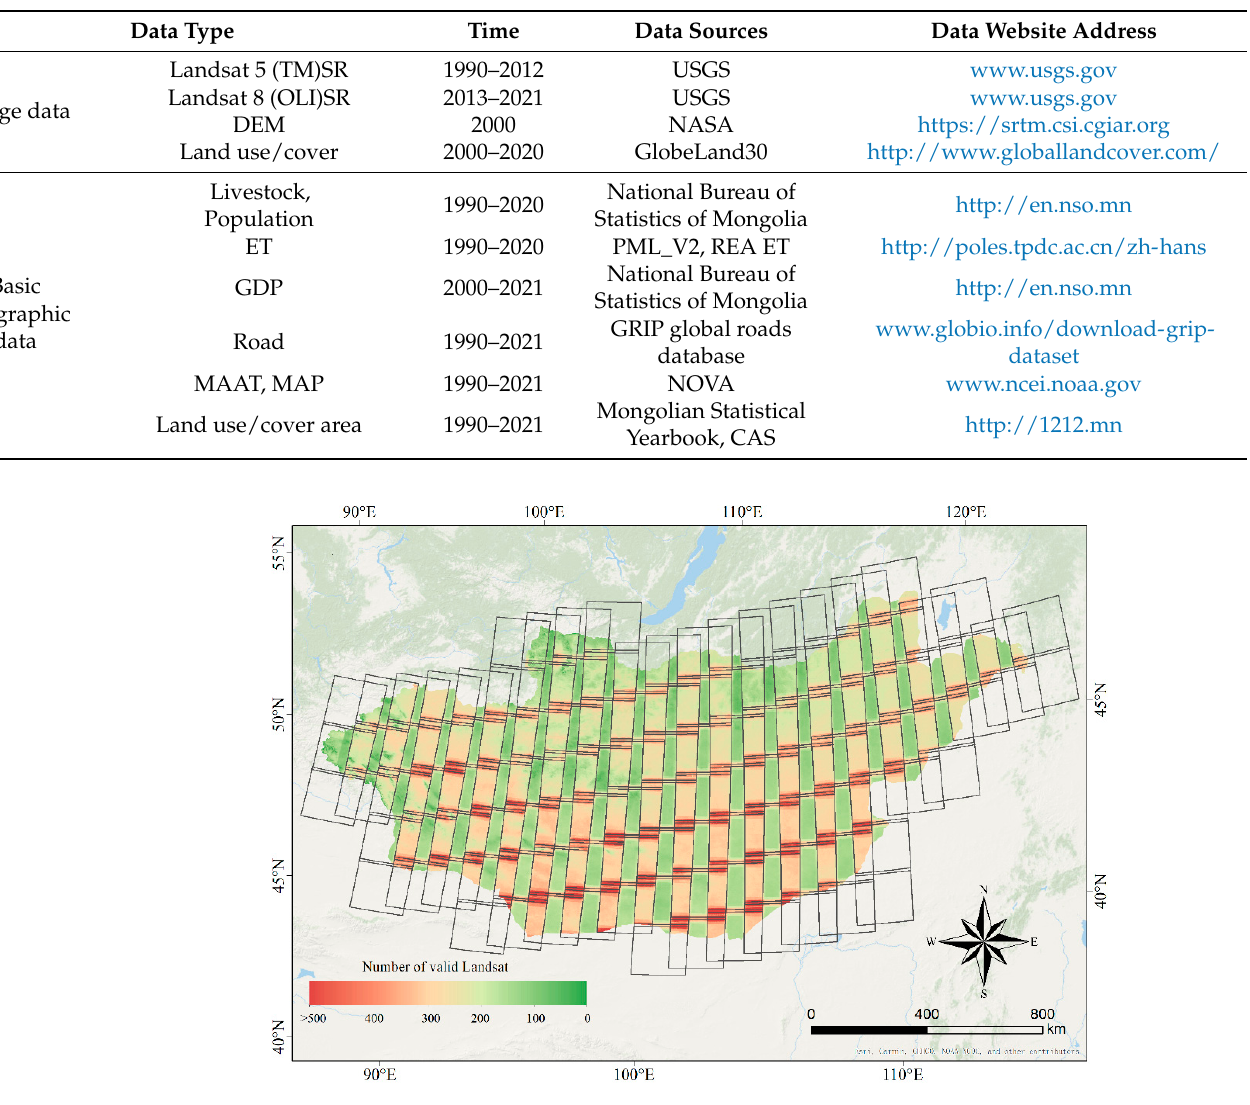
Figure 2. Effective number of Landsat images (cloud cover below 20%) of Mongolia from 1990 to